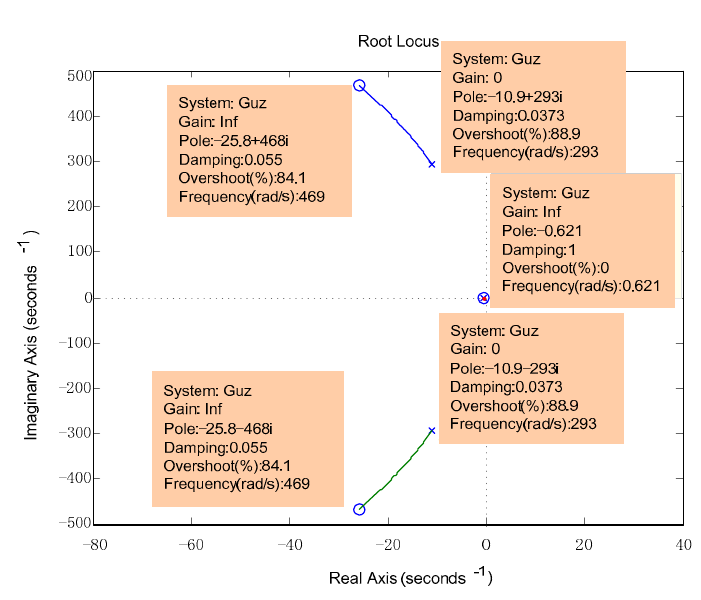
. θ w . FigureA6. Root locus of